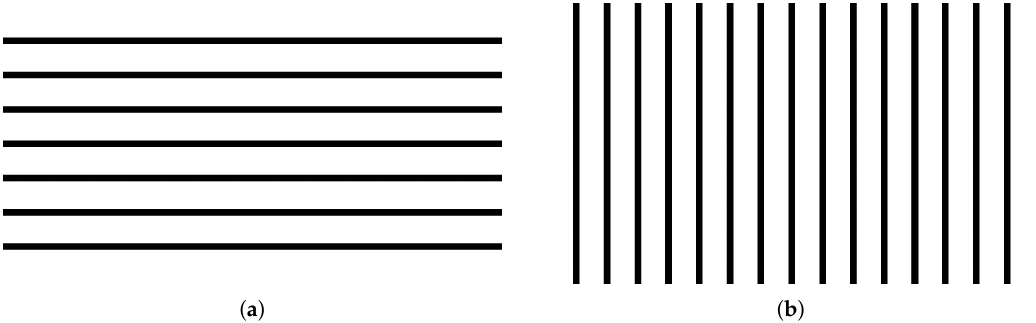
Figure 10. The line images for the line straightness error ratio test. ( a ) The lines image with seven horizontal lines. ( b ) The lines image with fifteen vertical lines. Table 3. Line Straightness Error Ratio results of the proposed correction